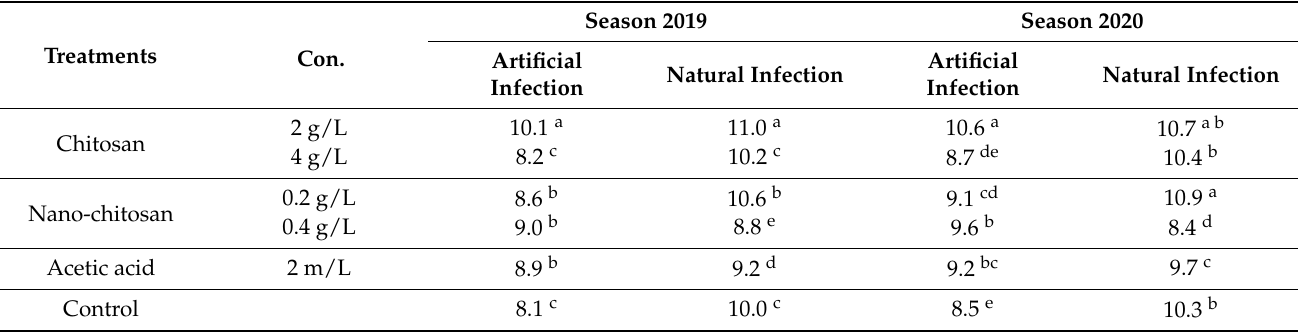
Table 5. Effect of chitosan and its nanoform on TSS% of Anna apples after 45 days of cold storage at 4 ± 1 ◦ C during seasons 2019 and 2020.